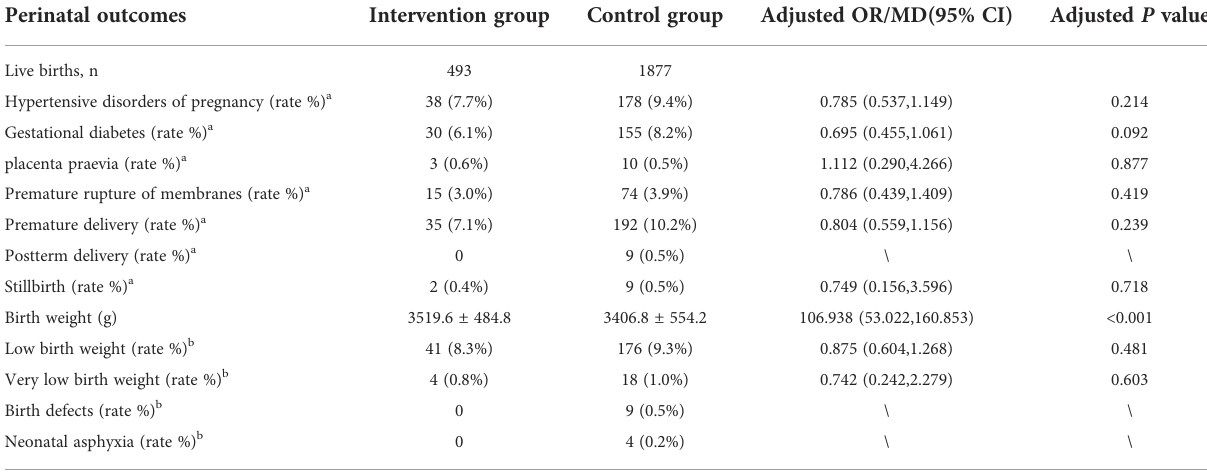
TABLE 3 Comparison of perinatal outcomes of the intervention group and the control group. Perinatal outcomes